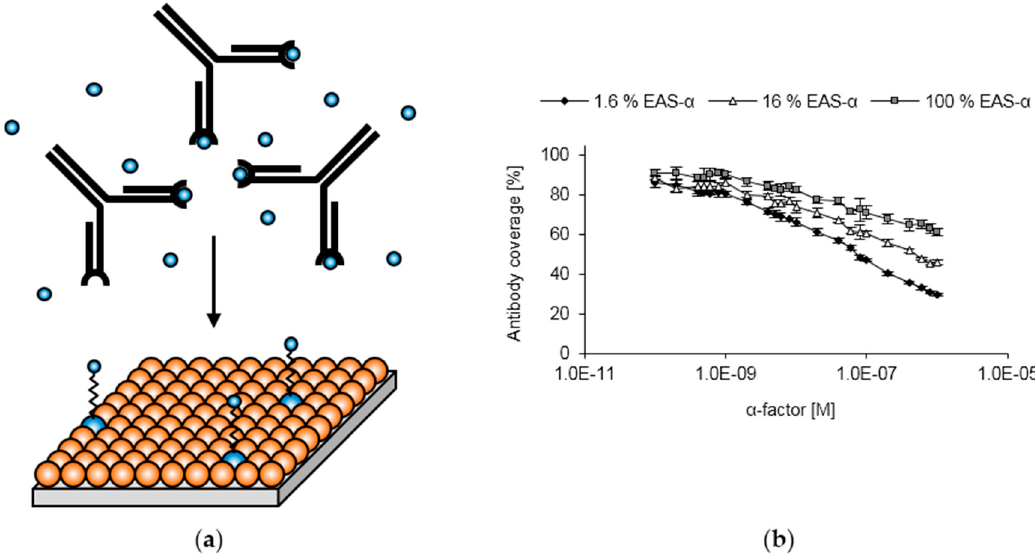
Figure 6. Concept and calibration of the inverse ELISA. ( a ) Schematic illustration of the inverse ELISA setup. In a first step, antibodies (black) are premixed with a sample containing the pheromone (small blue spheres) to occupy some of the binding sites of the antibodies. Subsequently, the antibody- pheromone mixture is applied to the functionalized surfaces. Only antibodies that still exhibit free binding sites are able to attach to the surface; ( b ) Calibration of the inverse ELISA. Several dilutions of the synthetic α -factor were premixed with the α -factor antibody. Afterwards, these samples were applied to polystyrene surfaces functionalized with EAS and EAS- α in different molar ratios.